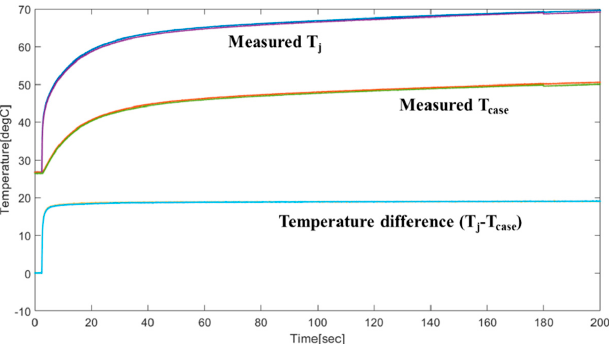
Figure 8. Measured (twice) temperature data: junction temperature, case temperature, and their difference.